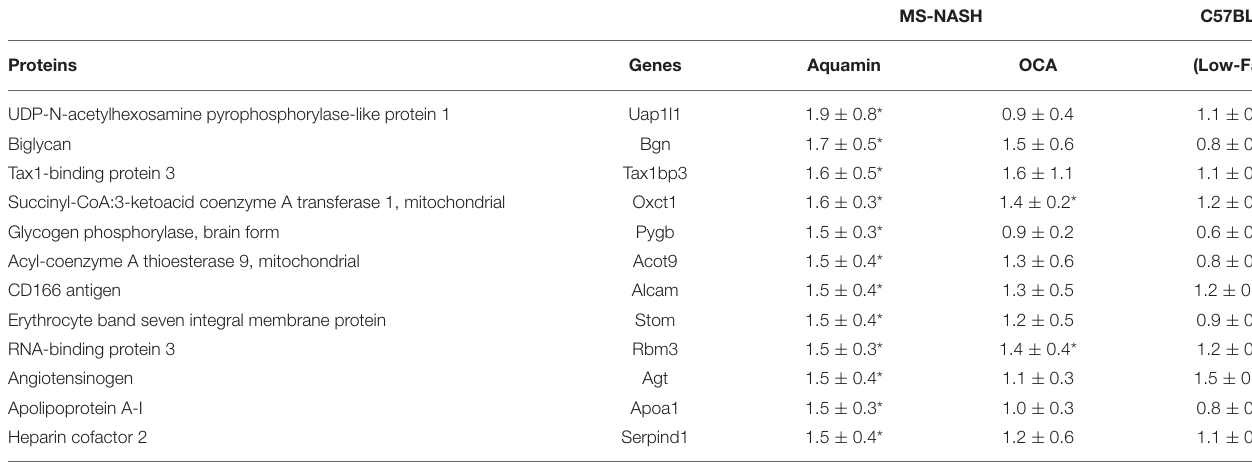
TABLE 1A | Significantly upregulated proteins with Aquamin in high-fat